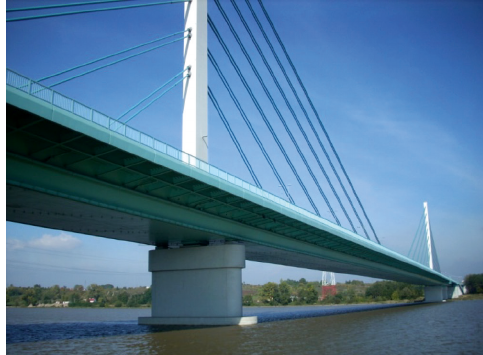
Figure 1. General view of the bridge under investigation